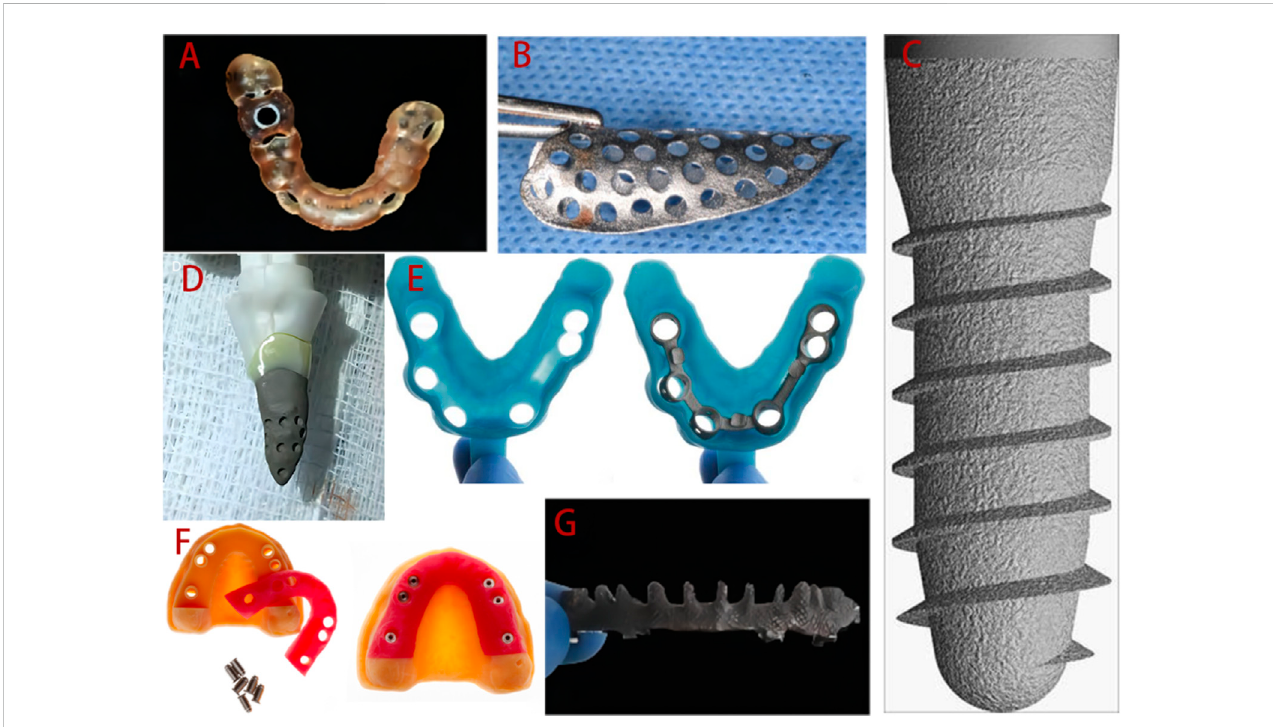
FIGURE 2 Applications of 3D printing technologies in implant dentistry clinical practice. (A) 3D printed surgical guide. (B) Personalized titanium mesh. (C) Standard implant. (D) Customized root-analogue implant. (E) Custom tray. (F) Implant models. (G) Implant framework. Adopted from (Mangano et al., 2012b; Revilla- Leon et al., 2017; Revilla-Leon et al., 2018a; Westover, 2019; Olea Vielba et al., 2020; Cucchi et al., 2021; Herschdorfer et al.,